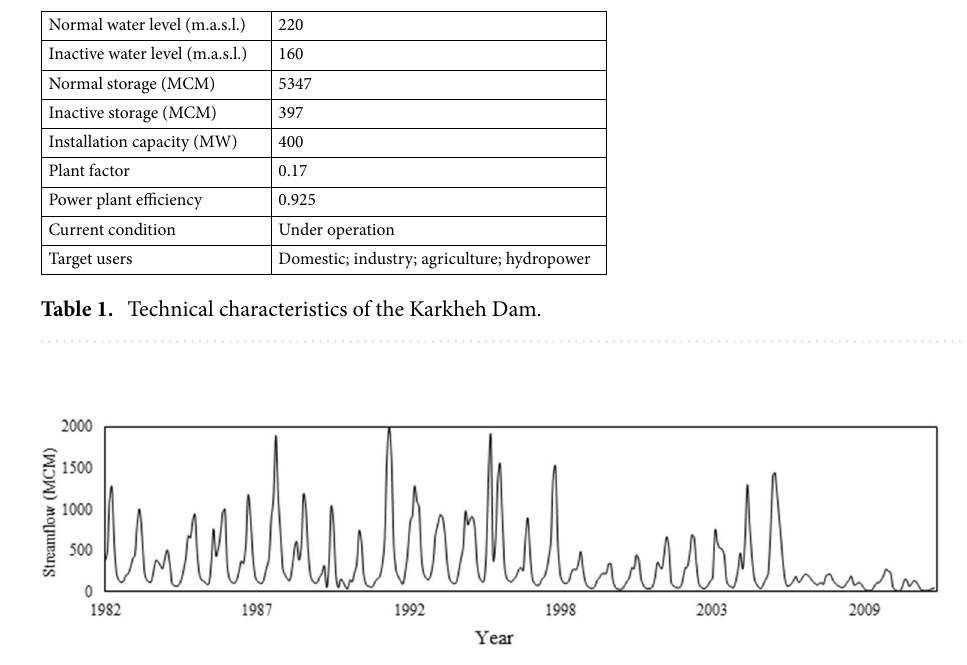
Figure 5. Observed streamflow time series under the status quo